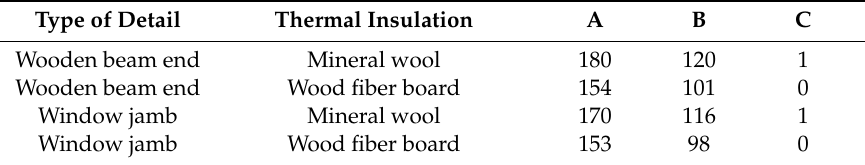
Table 3. Duration of favorable conditions for biofilms growth